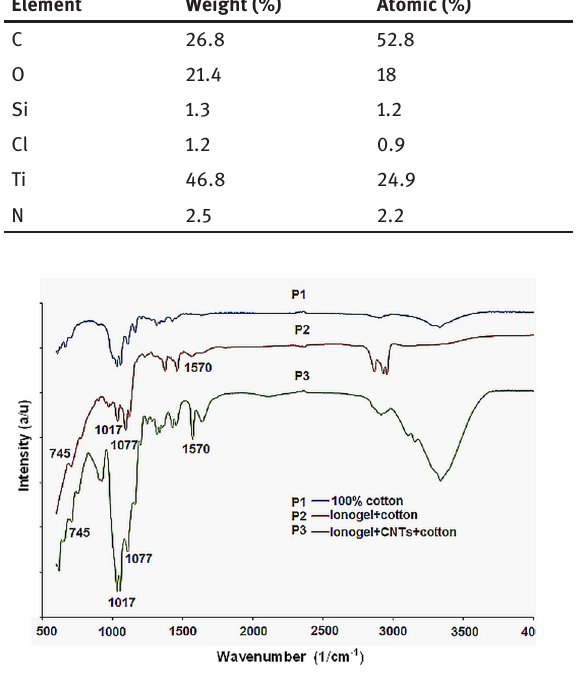
Figure 4: FTIR spectrum of P1) pure cotton; P2) cotton/MTICl/ Ti(OBu) ; P3) cotton/MTICl-Ti(OBu) 4 spectral range. Only major peaks are